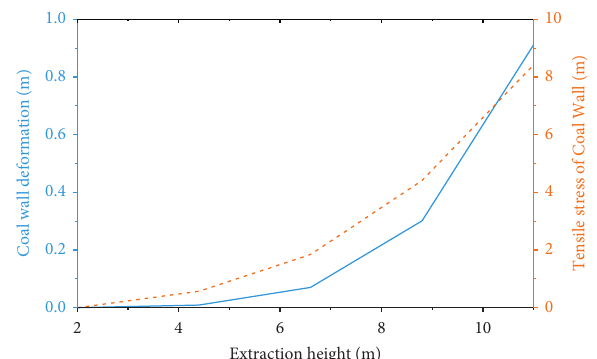
Figure 4: Influence of the mining height on the displacement and tensile stress in the coal